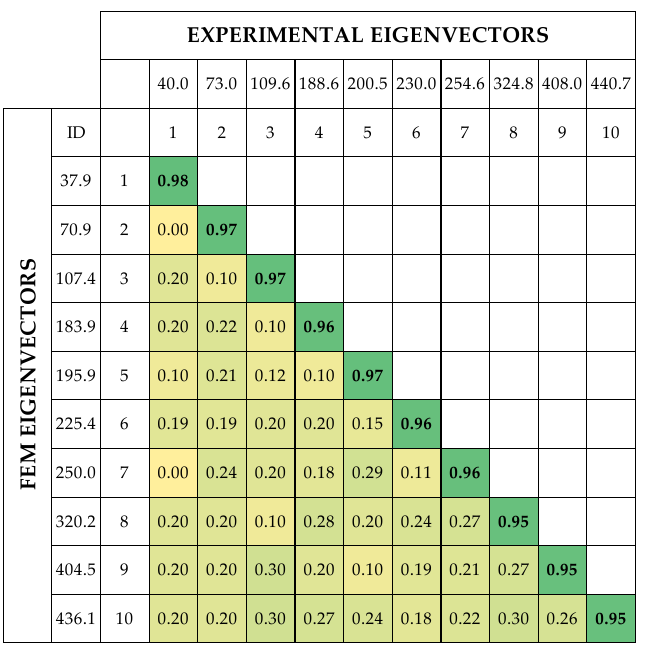
Figure 8. MAC matrix: mode shapes comparison. Table 2. Natural frequencies comparison among first 10 mode shapes.